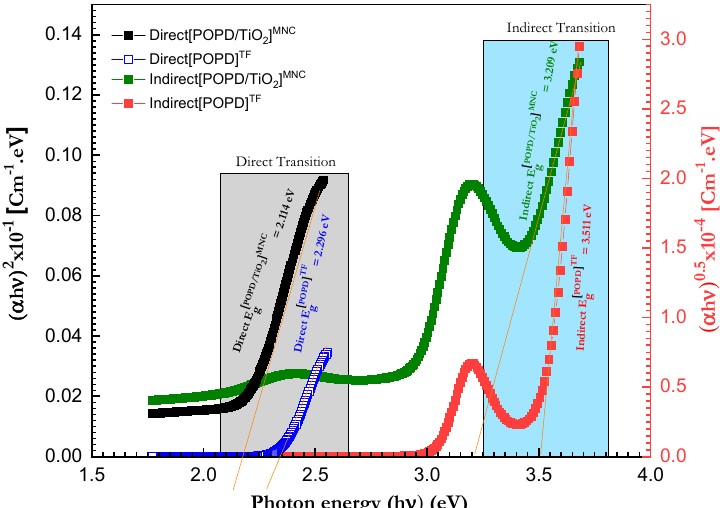
where h υ is the photon energy and γ = 1 for direct transition and 2 for indirect transition. Figure 8 shows the relation between ( α h υ ) γ and photon energy h υ for direct and direct transitions. The values of the optical energy gap E opt g for [PoPDA] TF and [PoPDA/TiO 2 ] MNC are 2.296 eV and 2.114 eV, respectively, in the case of direct transition, and 3.511 eV and 3.209 eV, respectively, in the case of indirect transition. The calculated values of the direct and indirect energy gaps show a significant decrease in the direct and indirect energy gap values by adding TiO 2 nanoparticles and indicate the preference for direct electron transition.